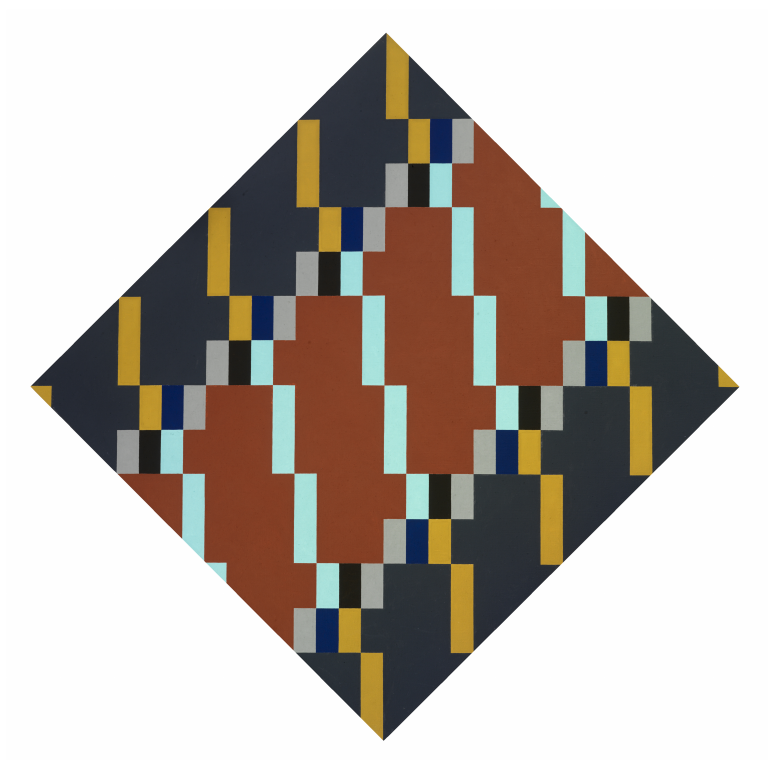
Figure 1: Syntagma Sg IV 118 , 2005, Oil on flax canvas, 146 x 146 cm. Copyright Jeffrey Steele, courtesy of Osborne